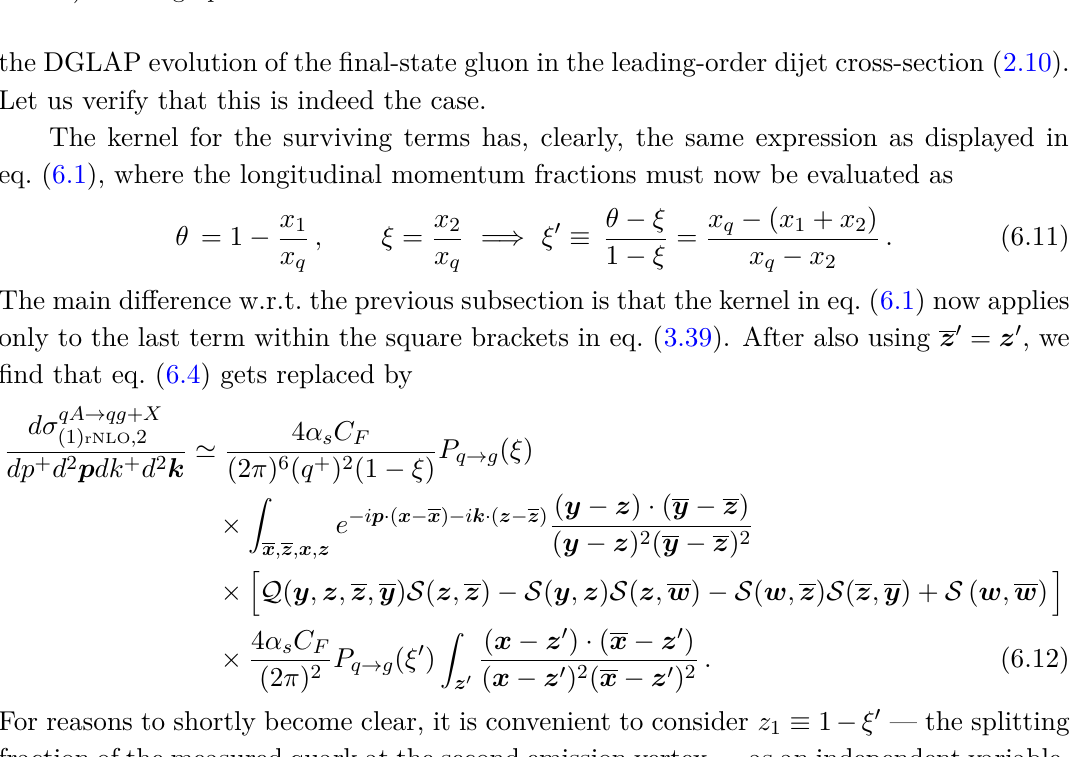
Figure 24 . The four graphs surviving in the collinear limit for the second gluon emission (depicted in blue). These graphs are void of final-state